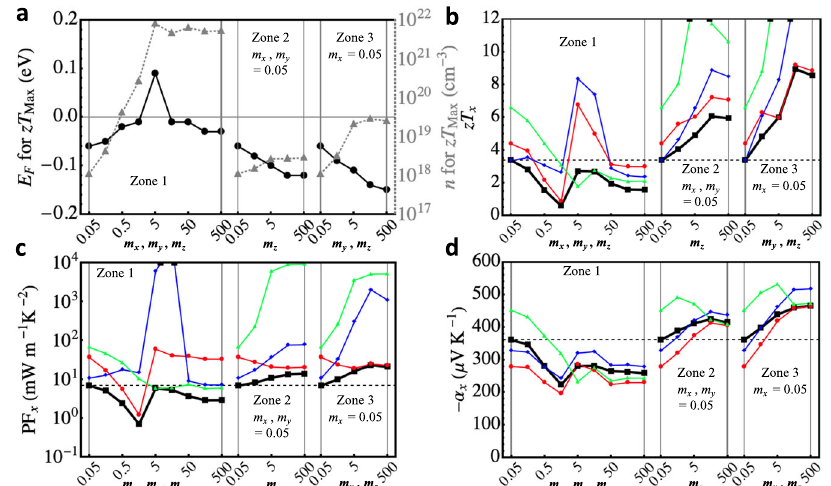
Fig. 3 Two-band thermoelectric properties in the light direction ( x ) with respect to the evolution the second band ’ s effective-mass pro fi le while the fi rst band is fi xed at m x = m y = m z = 0.05 with s int = 0.5. a Fermi level and carrier concentrations for optimum zT , b optimum zT , c the power factor, d and the Seebeck coef fi cient, in the x -direction. Each zone (as enclosed by vertical gray lines) indicates certain characteristic evolution of the second band: isotropic increase in m from 0.05 to 500 in Zone 1, anisotropic increase in m y from 0.05 to 500 in Zone 2, anisotropic increase in both m y and m z in Zone 3 from 0.05 to 500. Four different scattering regimes are considered: the POS limit (blue), the IIS limit (green), the DPS limit (red), and the overall effect (black). Supplementary results σ , μ , ζ , κ e , L , z e T are in Supplementary Fig. 10.